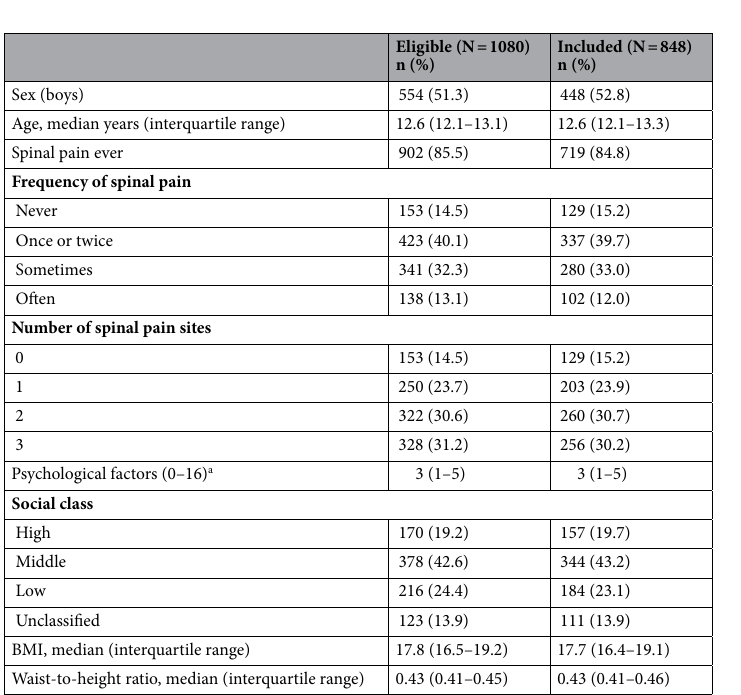
Table 1. Baseline characteristics of a population-based sample normal-weighted Danish children aged 11–13 years in 2010. a Measured at follow-up